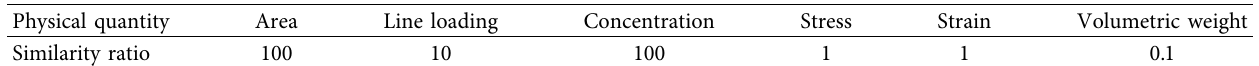
Table 3: Similarity relationship between physical quantities